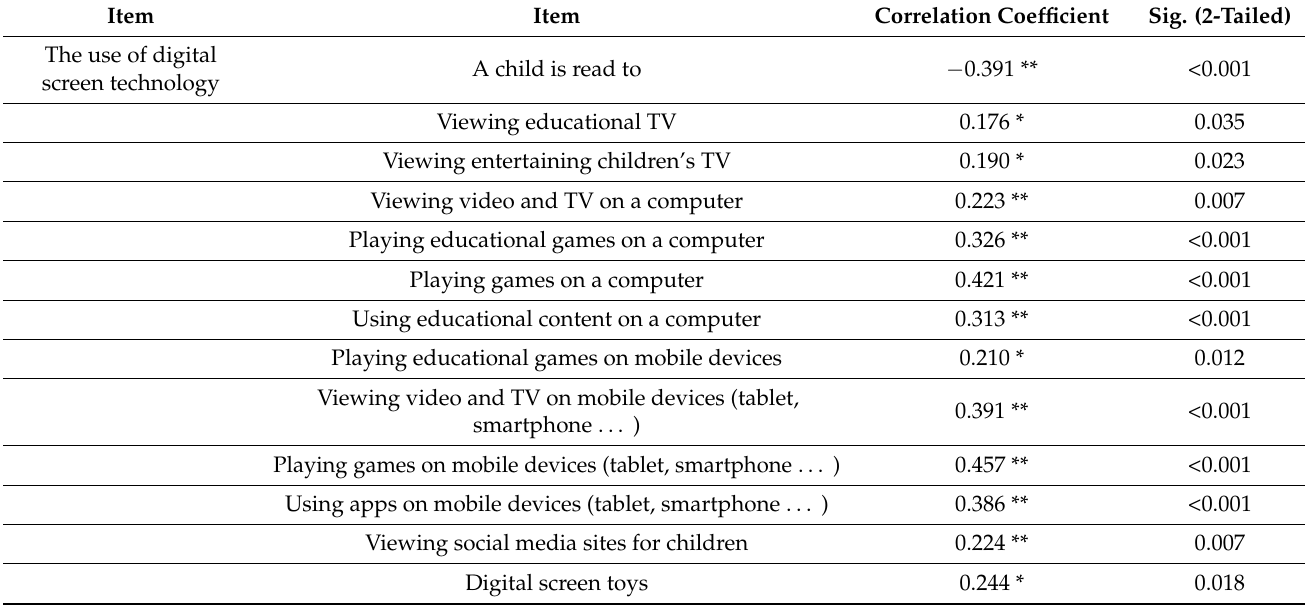
Table 3. Spearman’s correlations between the uses of digital screen technology with child’s daily activity; the significant correlations are presented.